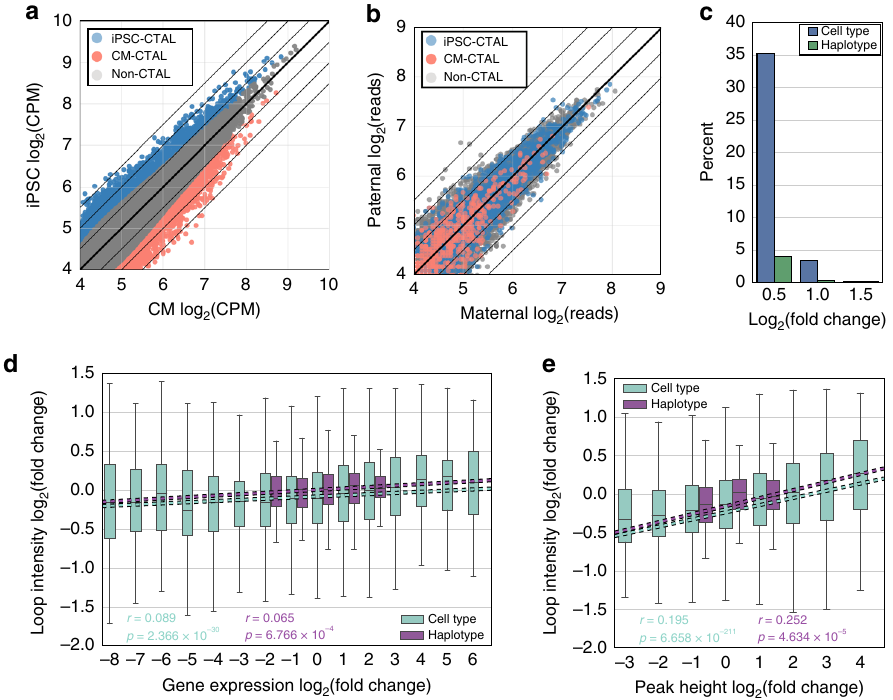
Fig. 7 Comparison of chromatin loop, gene expression, and H3K27ac variability across cell types and haplotypes. a , b Scatterplots showing a contact frequency in log 2 counts per million (log 2 (CPM)) across cell types or b read counts across haplotypes of all union loops colored by CTAL status. The solid bold line indicates the function y = x , and other lines indicate absolute fold changes of log 2 (0.5), log 2 (1), and log 2 (1.5). c Percent of loops with at least the shown log 2 (fold change) or across cell types (blue) or haplotypes (green). d , e Boxplot (all four quartiles shown via lower whisker, lower half of box, upper half of box, and upper whisker; lines indicate median; outliers not shown) showing the log 2 (fold change) of chromatin loop contact frequency for chromatin loops overlapping a d differentially expressed or ASE gene, or e differential or ASE H3K27ac peak, binned by the log 2 (fold change) of the d gene or e peak. Boxes are shown for cell type comparisons in teal, and haplotype comparisons in purple, linear regressions are plotted with dashed lines, and r ’ s and p - values are shown and colored from the raw data in each dataset independently. For all data, positive fold change indicates stronger counts in iPSCs, and negative fold change indicates stronger counts in